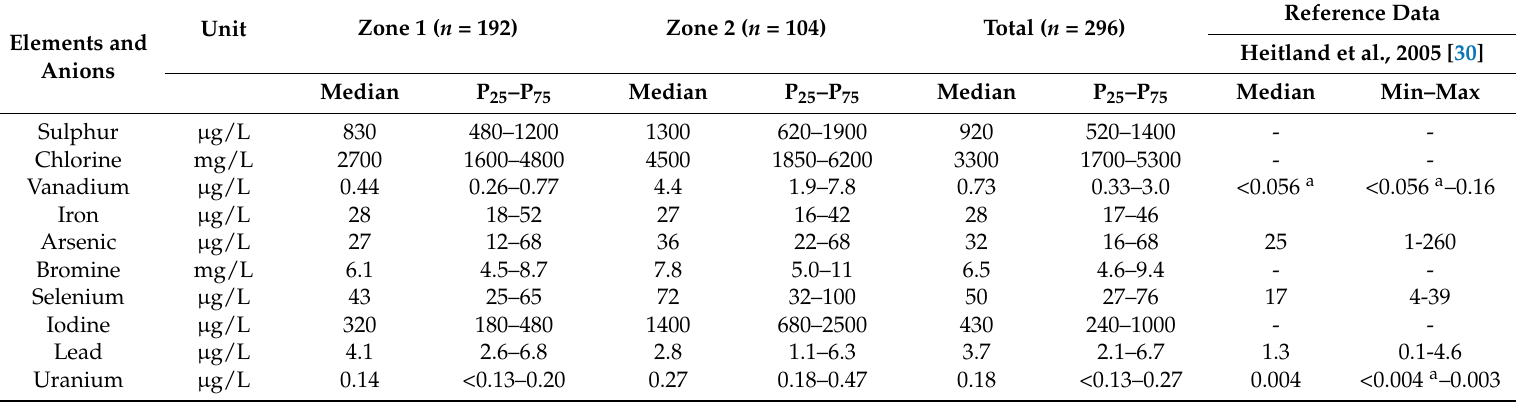
Table 5. Concentration of elements in urine among Saharawi children from Zones 1 and 2 in comparison with other published data.